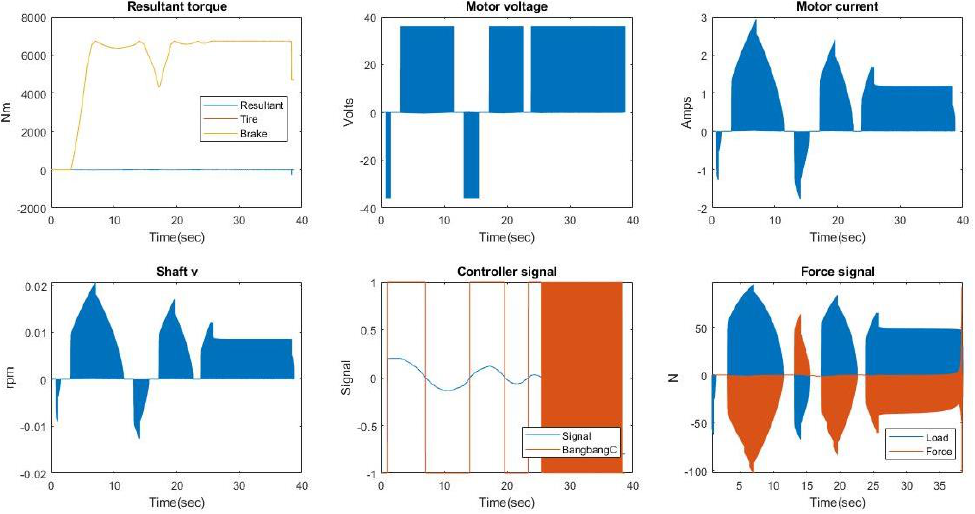
Figure 3. Actuator and ABS Data.